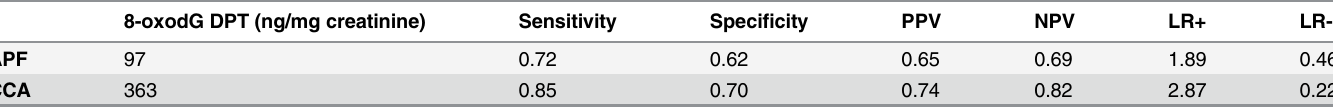
Table 3. Urinary 8-oxodG diagnostic positivity thresholds (DPT) and corresponding diagnostic validity parameters can be implemented in the clin- ical setting to detect advanced periductal fibrosis (APF) or cholangiocarcinoma (CCA) in individuals resident in Opisthorchis viverinni endemic